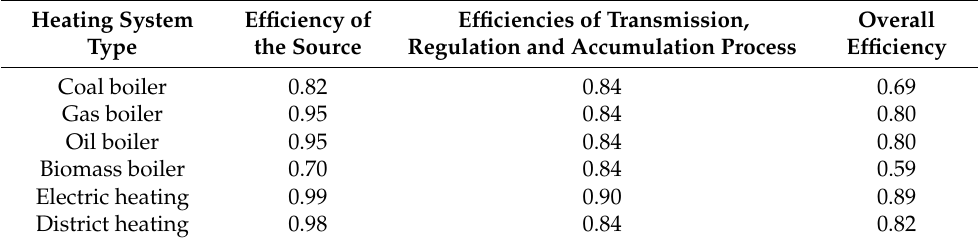
Table 2. Coefficients of efficiencies of various heating